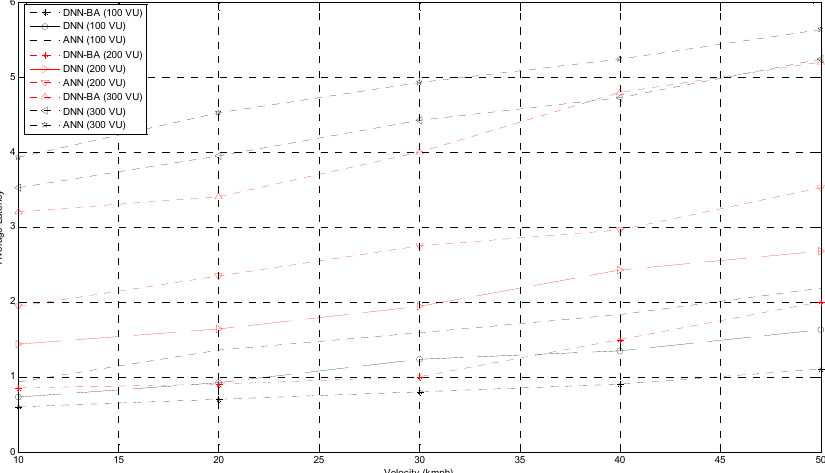
Figure 6. Impacts on average latency with variable velocity.